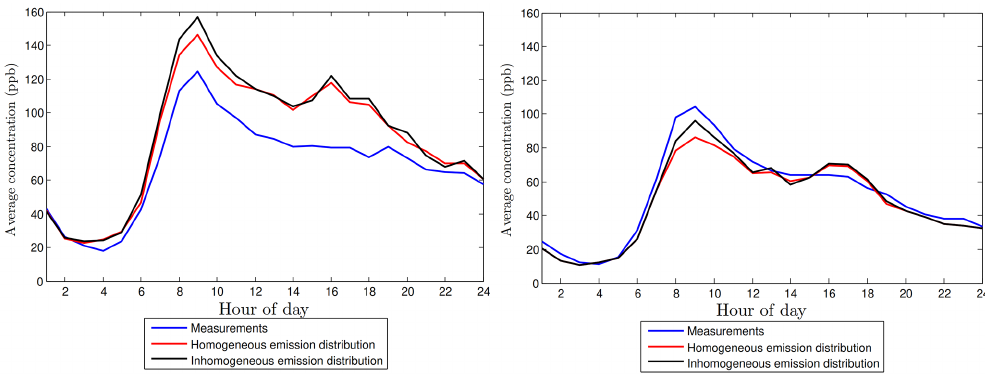
Figure 11. Diurnal variation in NO x concentrations on weekdays for 2003 (left) and 2013 (right).